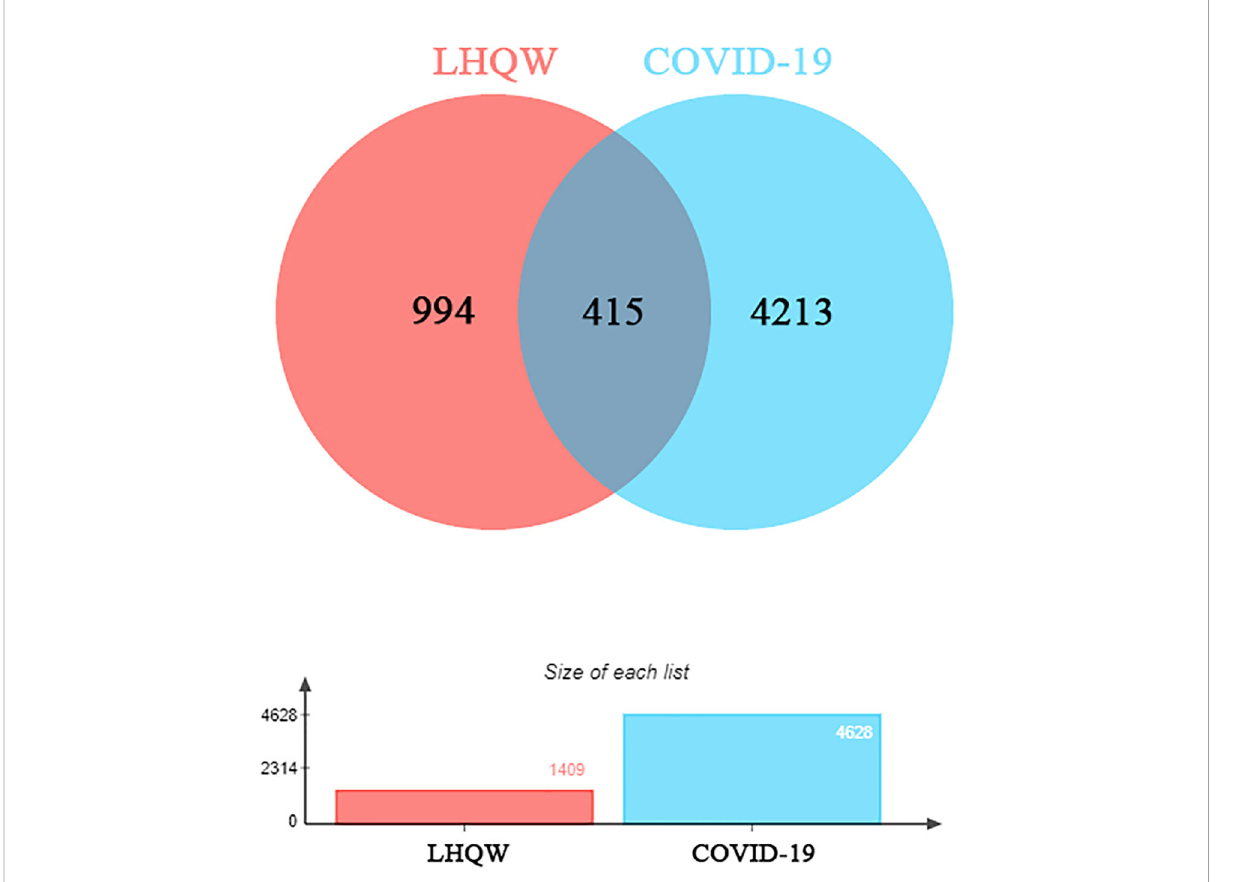
FIGURE 1 The venny of intersection gene targets. Targets of the intersection of Lianhua Qingwen granules (LHQW) and COVID-19.